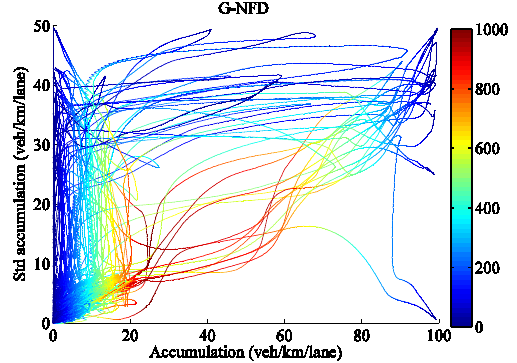
Figure 7. The performance (veh/h/lane) as function of the accumulation and the spatial spread of density, the Generalised